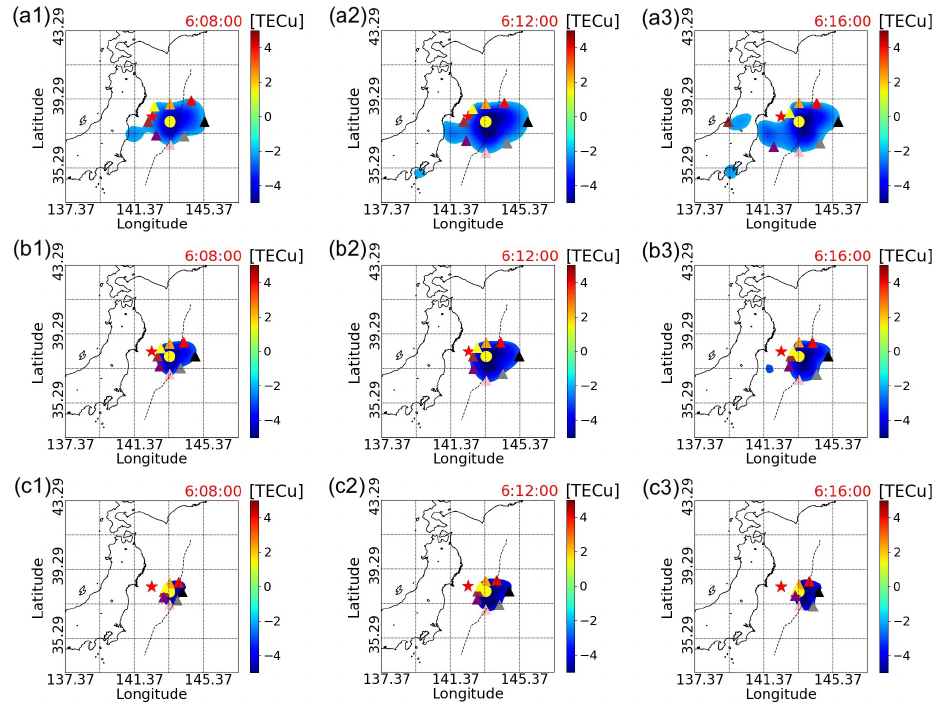
Figure 8. Expansion of the tsunami ionospheric hole. Panels (a1–a3) are plots of the TIH with TEC less than or equal to − 2. Panels (b1– b3) and (c1–c3) are less than or equal to − 3 and − 4, respectively. These plots are at 06:08:00, 06:12:00, and 06:16:00 (UTC). The eight triangles are the south, north, west, east, northeast, southeast, northwest, and southwest directions from the tsunami source, respectively. The colors are pink, orange, brown, black, red, grey, yellow, and purple, respectively. The red-star mark is the location of the epicenter. The yellow-circle mark is the location of the estimated tsunami source. The black dashed line indicates the location of the axis of the Japan